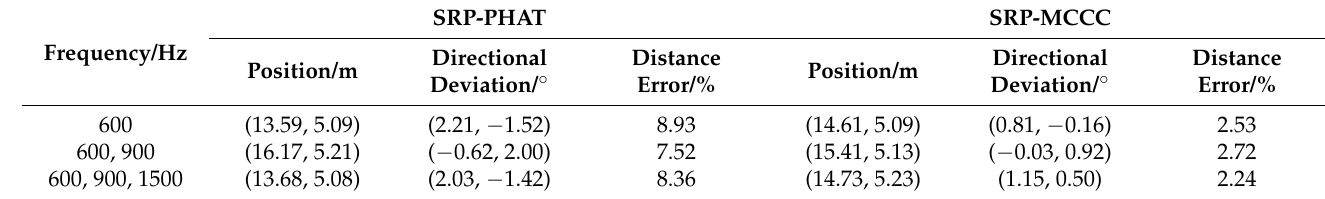
Table 3. Simulation results for different frequencies (SNR = − 10 dB, (15,